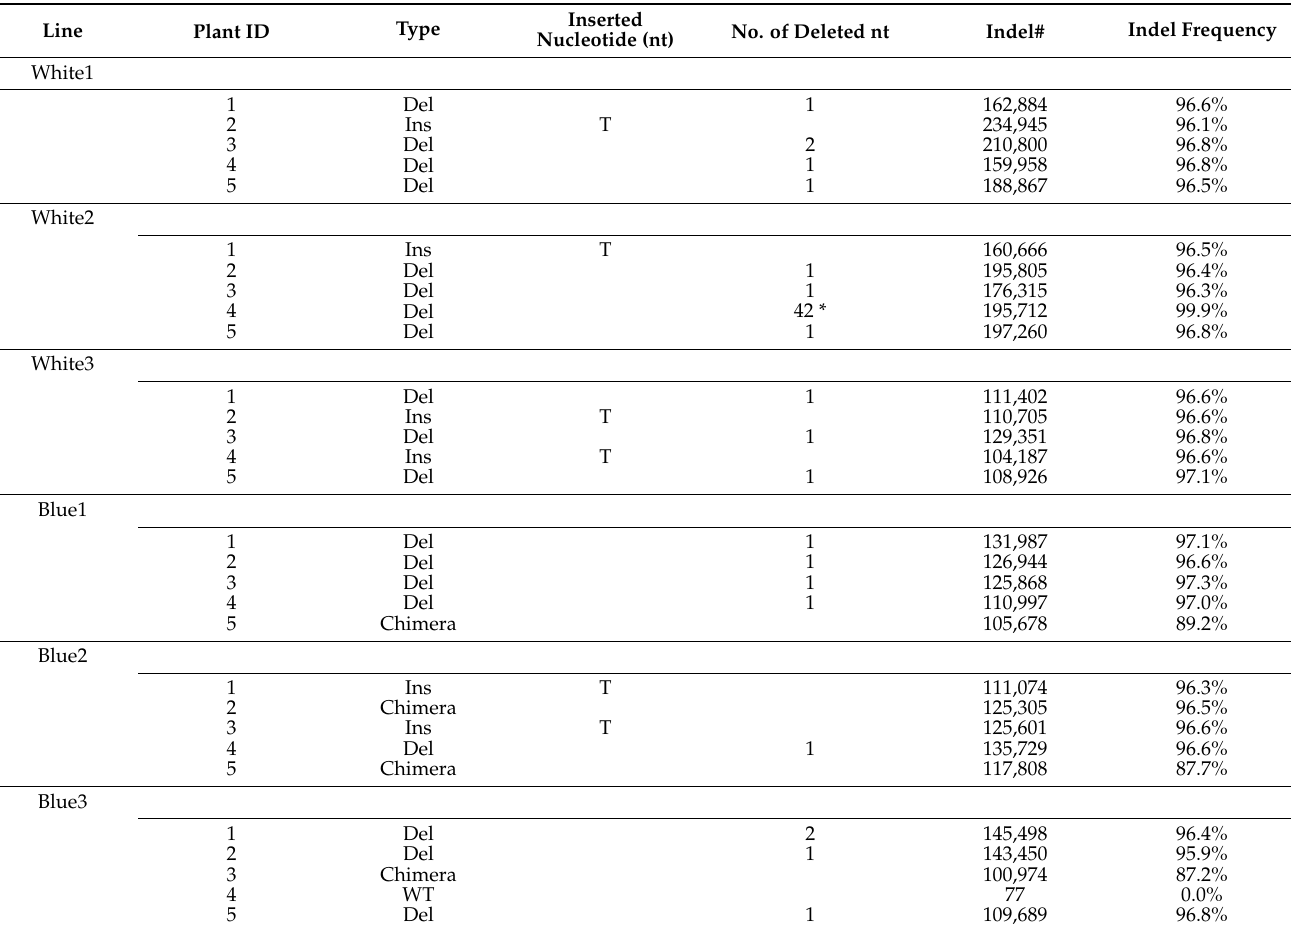
Table 4. Profiles of major mutations for the gRNA2 site in 30 transgenic plants produced through a second round of regeneration from six T 0 transgenic lines, including three white lines without GUS staining and three blue lines with light blue color representing edited gusA camera. These T 0 transgenic lines were from experiment #1, and profiles of the mutations in these lines were not available. WT: non-edited sequence. Del: Deletion. Ins: Insertion. Chimera: Mixture of various edited